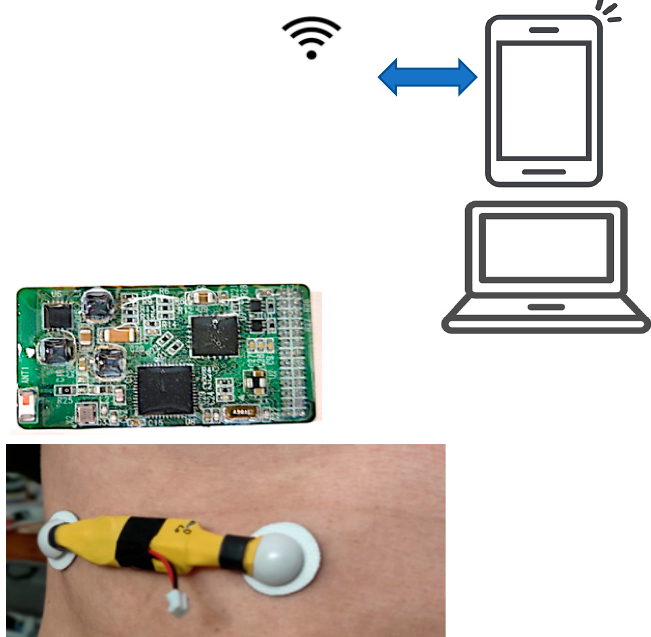
Figure 2. Overall system block diagram.